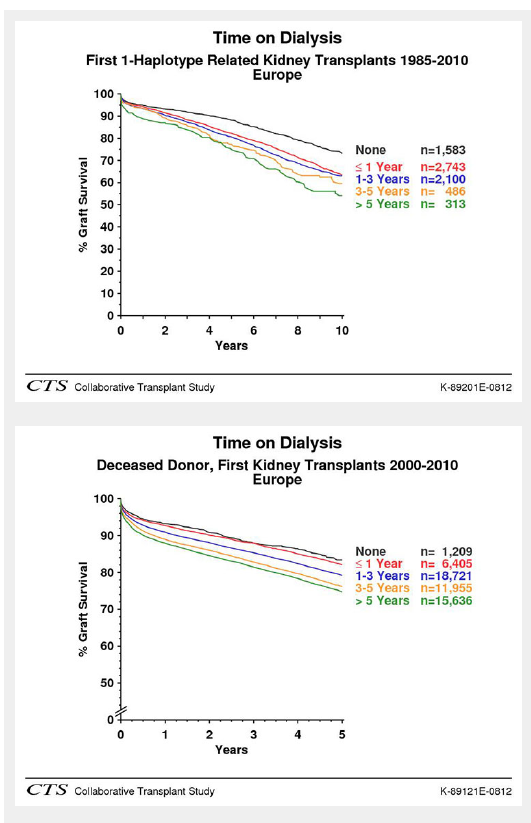
Impact of time on dialysis on graft survival after living donated (left panel) and deceased donor (right panel) kidney transplantation